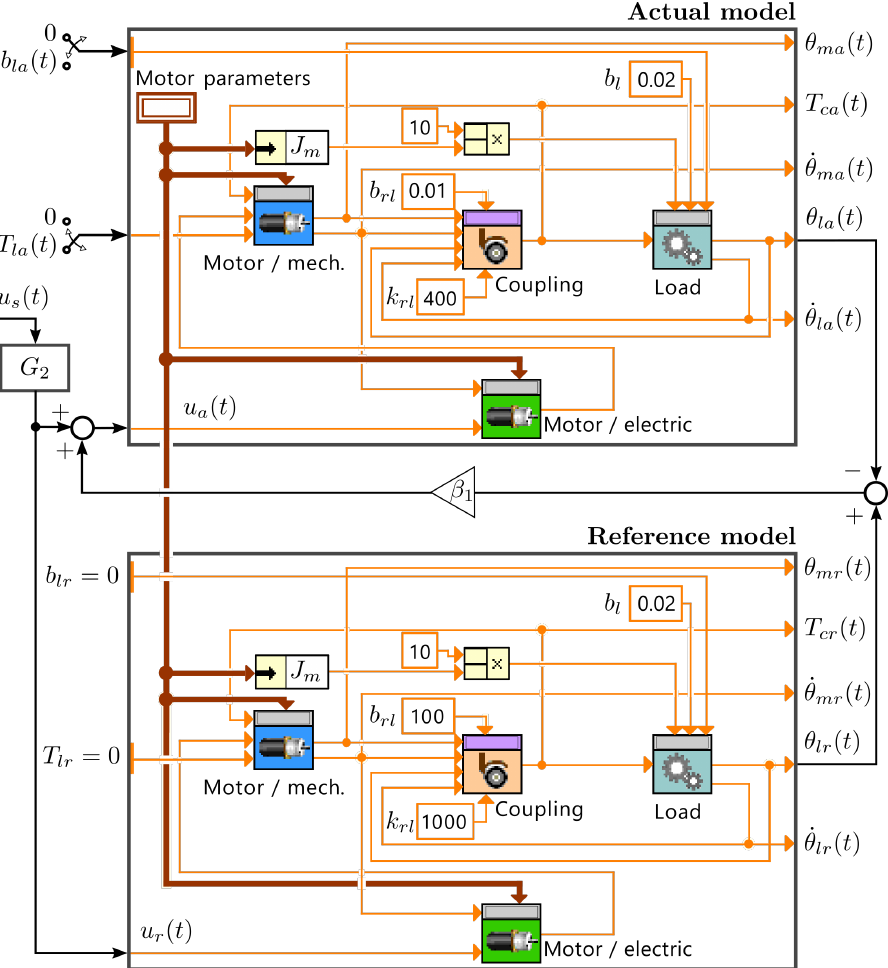
Figure 2. Block diagram of the open-loop model reference control system with the additional time- dependent loading disturbance T la ( t ) , while variation of the additional damping coefficient b la ( t ) is turned off, G 2 is the second-order dynamical operator given by Equation